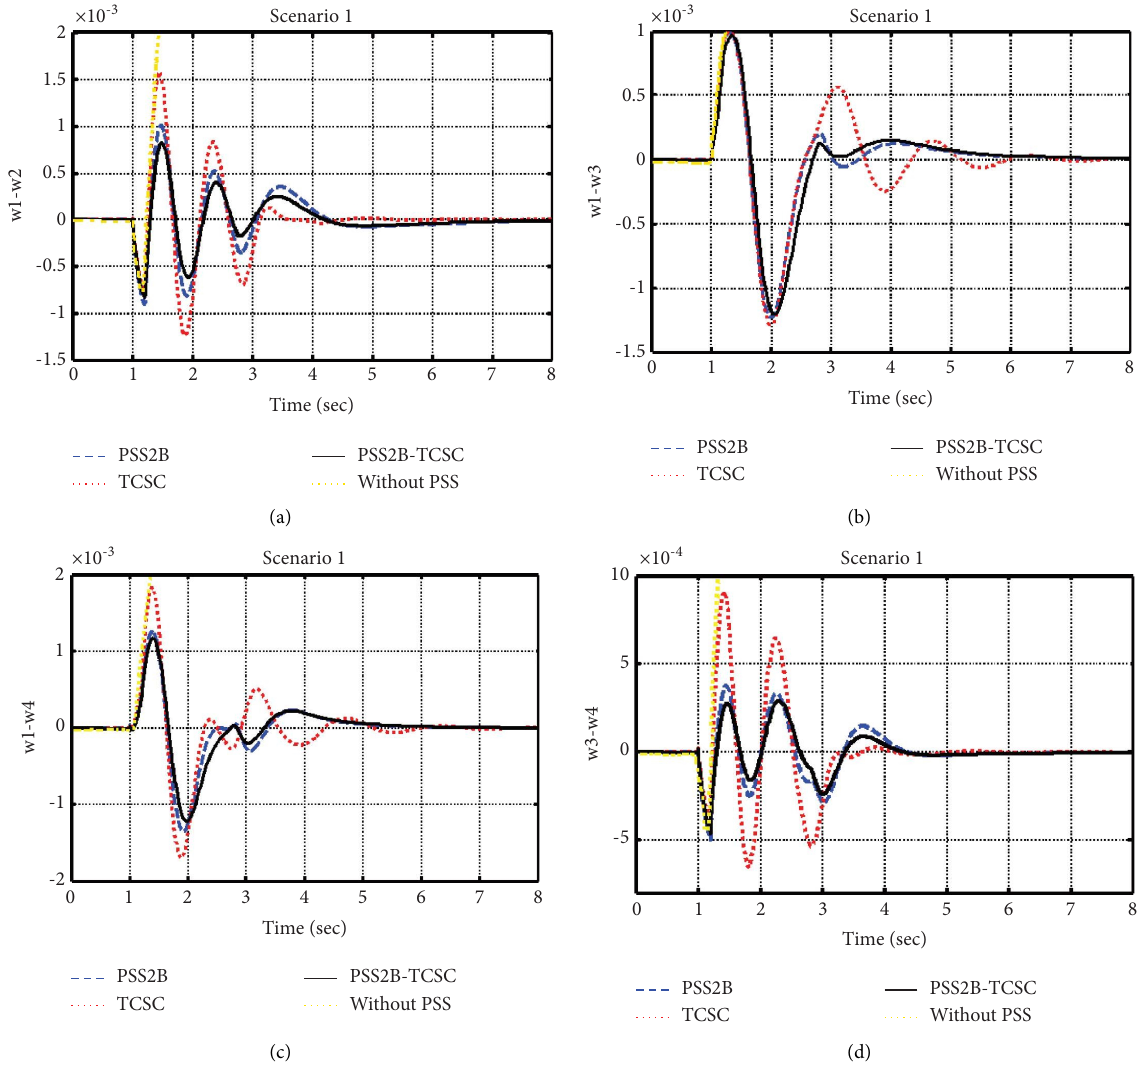
Figure 15: Te interarea and local modes oscillations in the frst